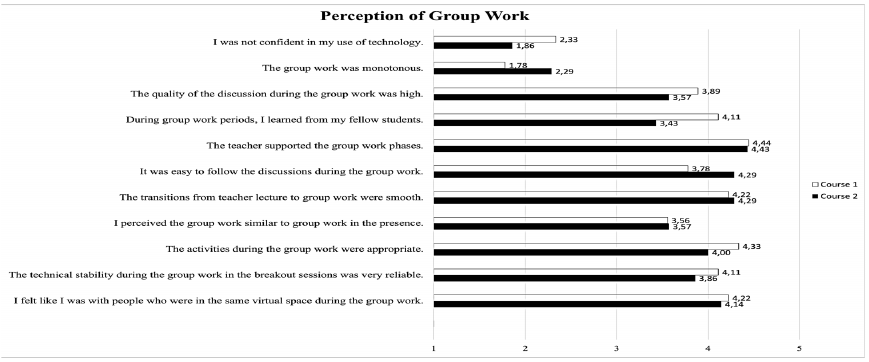
Fig. 3. Perception of group work in online courses, questionnaire based on [29], [30]. The bars depict the mean value, scale from 1 (not at all) to 5 (fully agree), n=9 (Course 1)